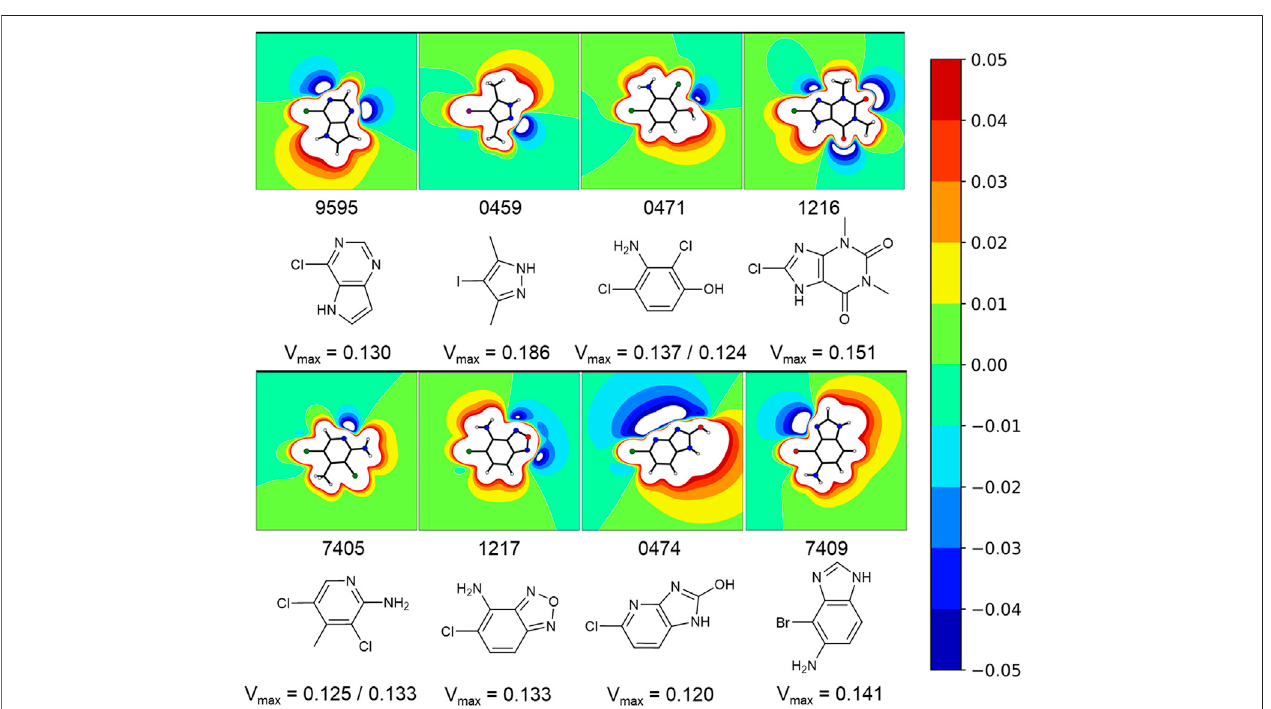
FIGURE 4 | Exemplary fragments and their respective electrostatic potential (ESP) plots. The most common protomer at pH 7 was chosen for each fragment. The most likely protonation state at pH 7 was chosen using MOEs Protomer Generation (2019.0102). A reddish color marks electron de fi cient regions, whereas blues mark electron rich regions. The fi rst of two values corresponds to the halogen atom oriented to the left. Depicted fragments vary within the magnitude of the σ -hole, as well as thehalogenbondingmotif.TheESPoffragment0474issplitalongtheCl-C-bondwithanegativepotentialontheonesideandapositivepotentialontheotherside. A completely different halogen bonding motif can be seen for example in fragment 0459 or